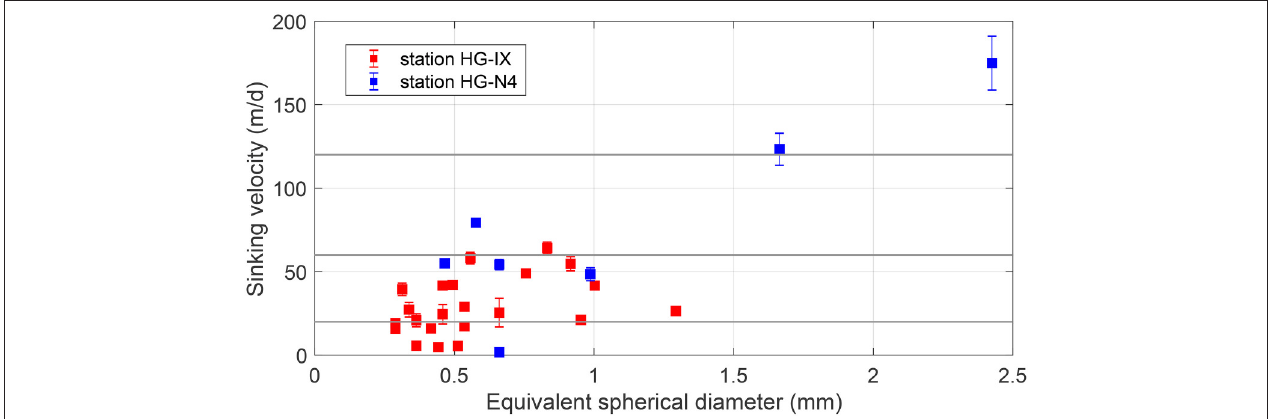
FIGURE 8 | Sinking velocity, its standard deviation and the associated equivalent spherical diameter of aggregates, measured during RV Polarstern expedition PS99.2 in summer 2016 at stations HG-IX (close to the Molloy Deep) in 80 m depth and HG-N4 in 20 m depth. Gray lines indicate settling velocities of 20, 60, and 120 m/d used in this